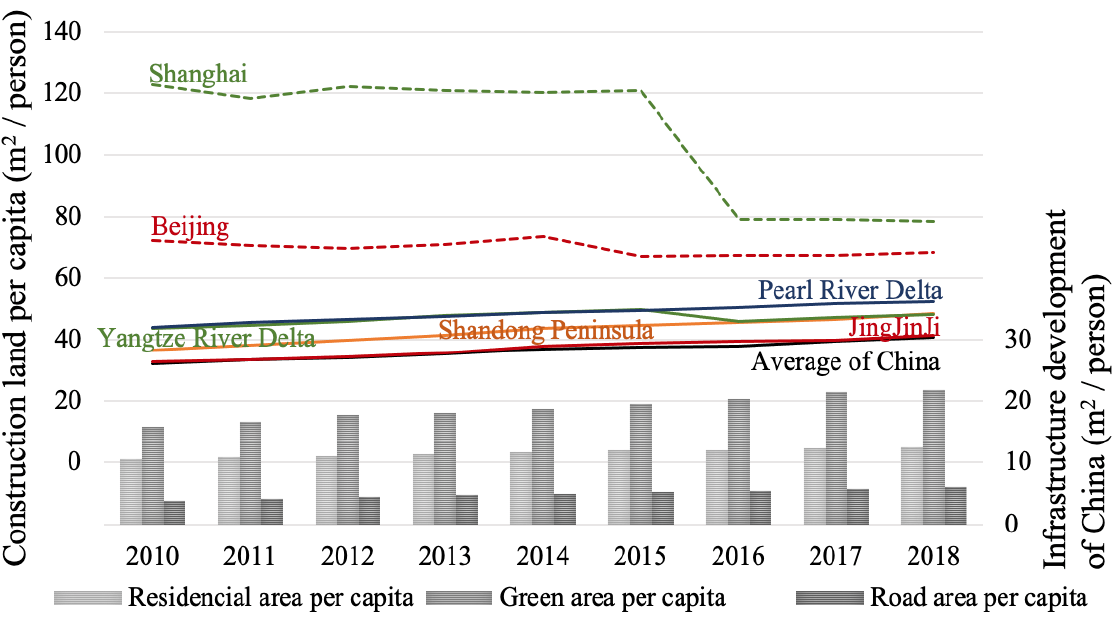
Figure 4. The trend of infrastructure development in China from 2010 to 2018. (Data source: China Statistical Yearbook 2011 – 2019 [36]).